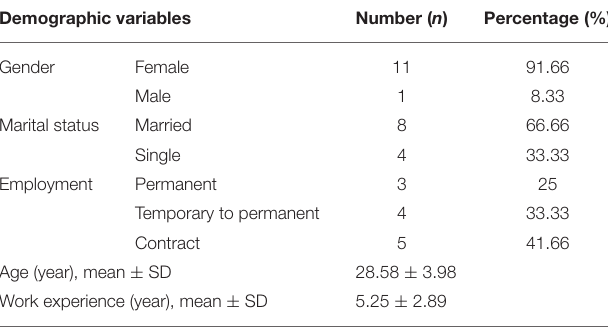
TABLE 1 | Demographic information of the nurses participating in the study. Demographic